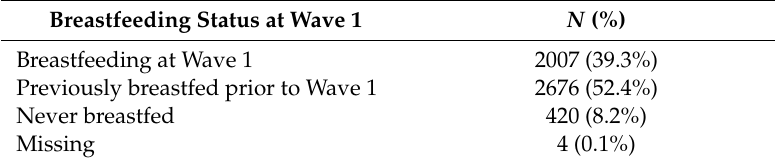
Table 1. Descriptive statistics for wave 1 breastfeeding status prior to multiple imputation